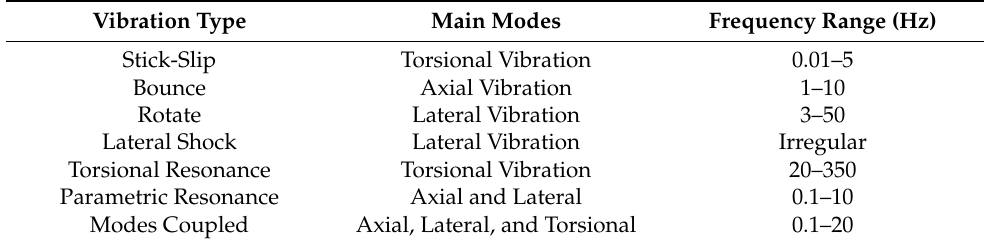
Table 1. The characteristics of the vibration signal in